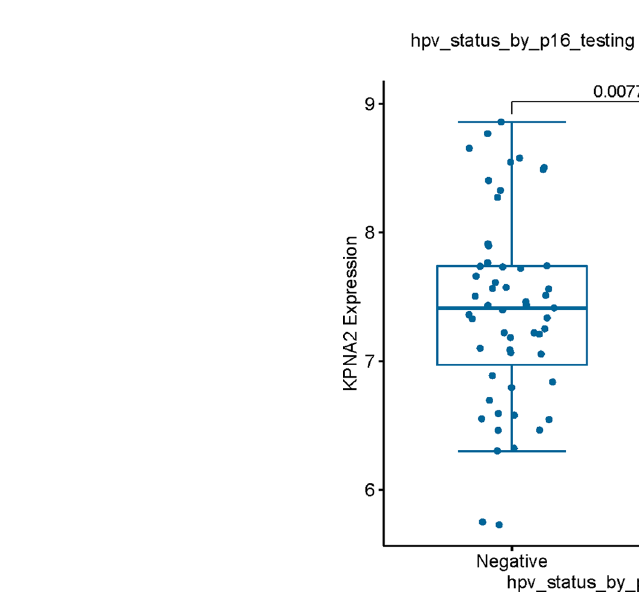
Frontiers in Oncology |